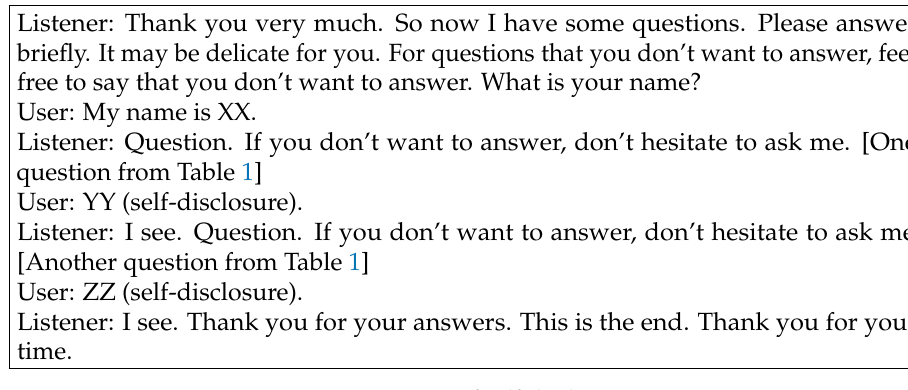
Figure 5. Script of Self-disclosure. Table 1. Topics in actual self-disclosure